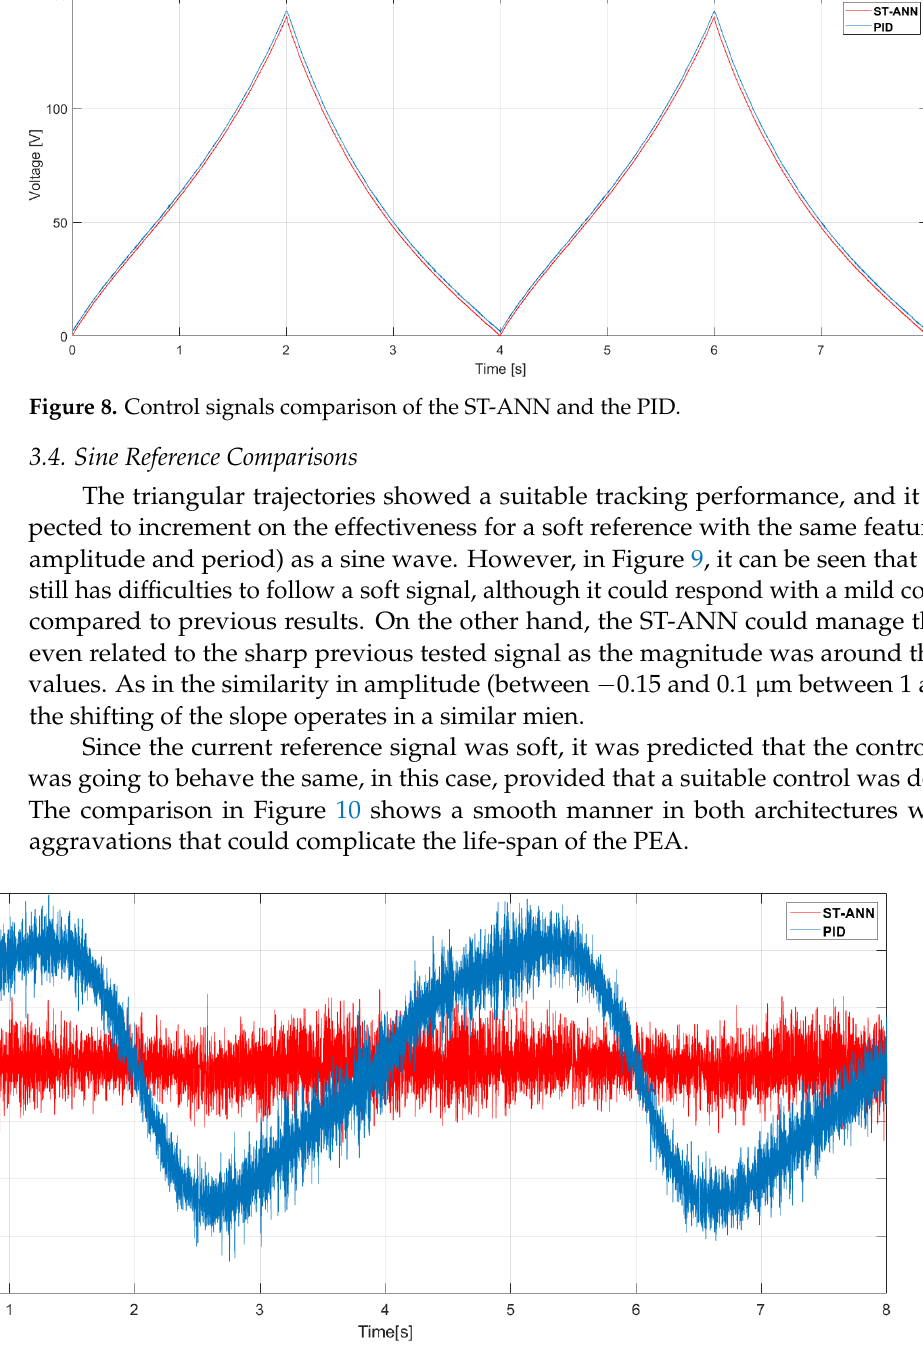
Figure 9. Error comparison between the ST-ANN and the PID structures for a sine wave tracking